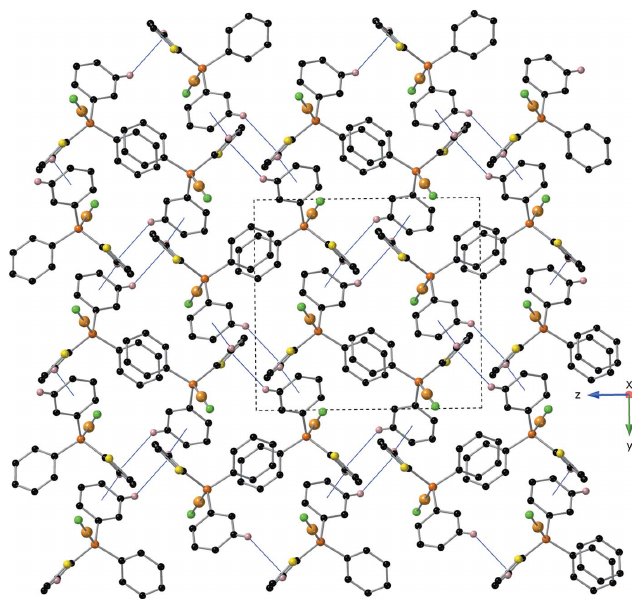
Figure 3 The crystal packing of the title compound as viewed down the a -axis, depicted using a ball-and-stick model with standard CPK colors (Au = tan , Cl = green, H = light pink). Intermolecular C—H (cid:2)(cid:2)(cid:2) (cid:2) interactions are shown with solid, blue lines. For clarity any hydrogen atoms not involved in a C—H (cid:2)(cid:2)(cid:2) (cid:2) interaction have been omitted. Only Part 1 is